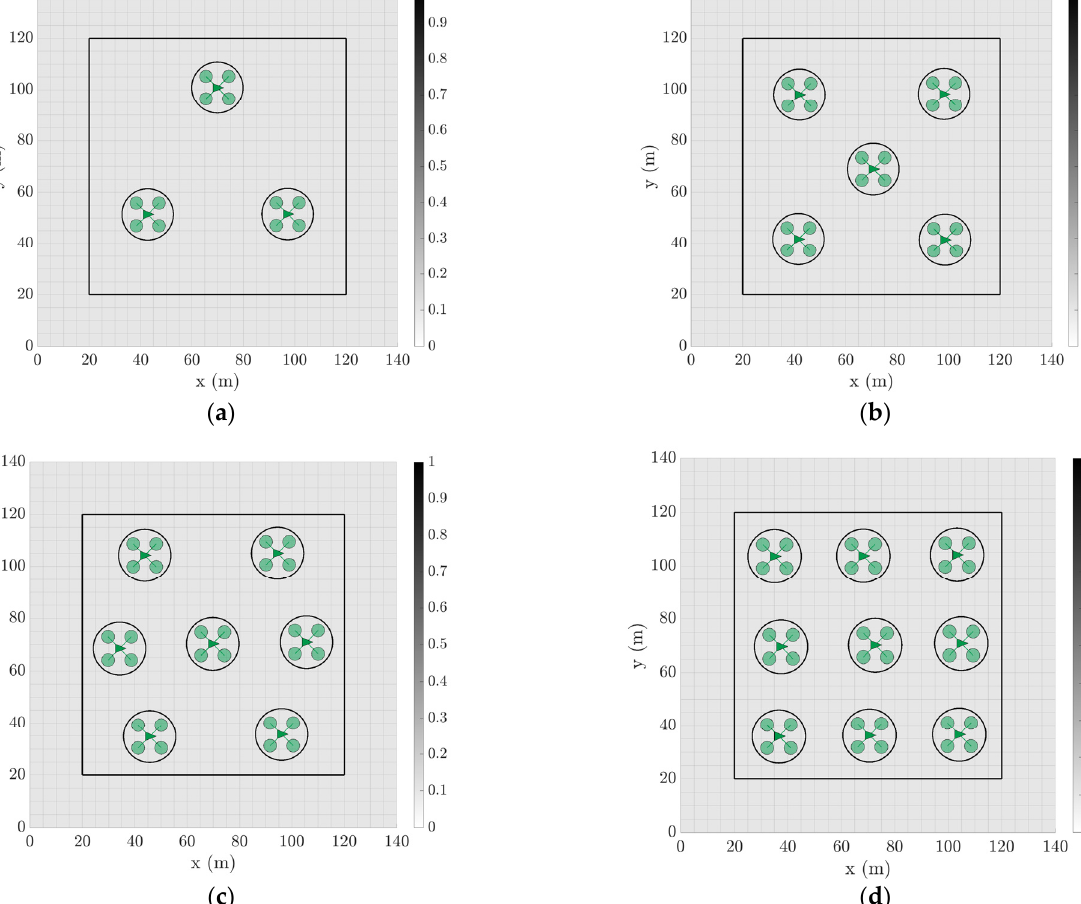
Figure 7. Sample grids with differing agent numbers generated using CVT method (all with 𝑅 (cid:3021) = 10 m ). ( a ) n = 3 agents; ( b ) n = 5 agents; ( c ) n = 7 agents; ( d ) n = 9 agents. R T = 10 m). ( a ) n = 3 agents; ( b ) n = 5 agents; ( c ) n = 7 agents; ( d ) n = 9